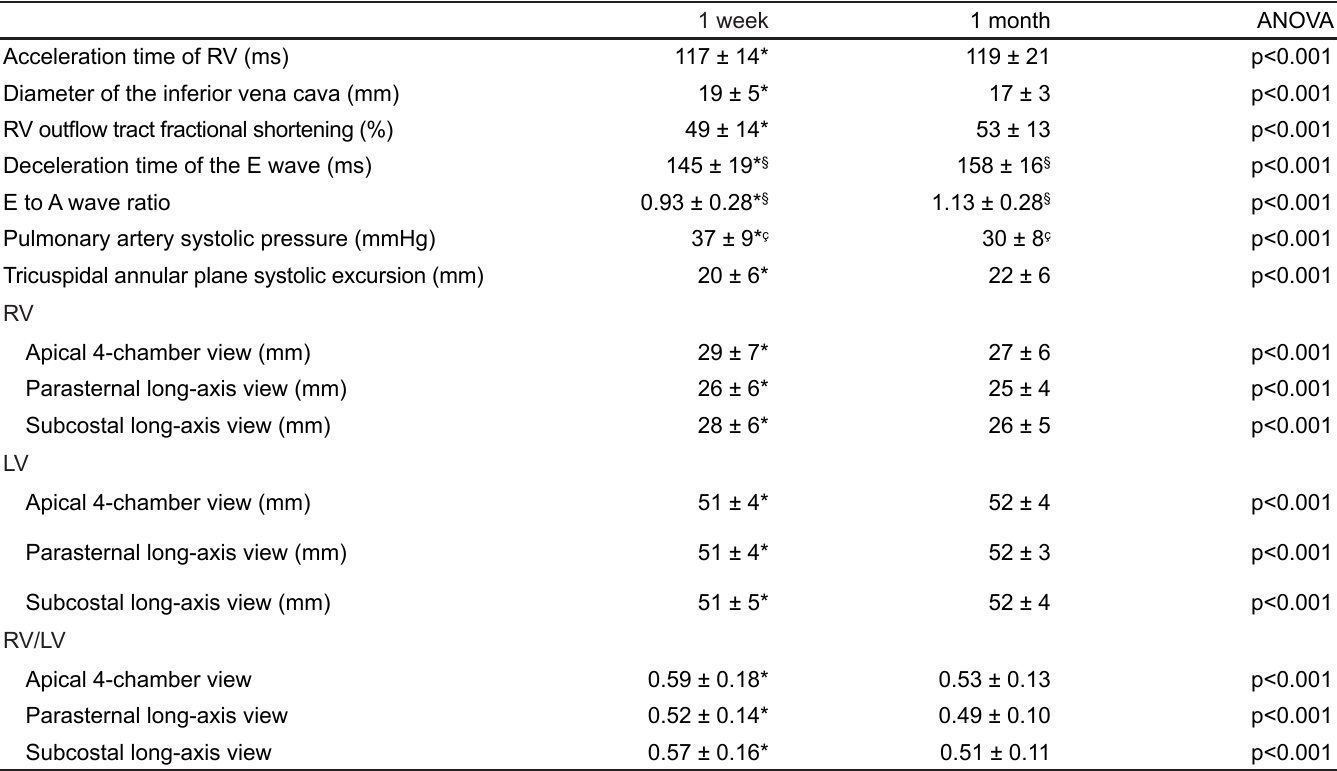
Table 2. Result of the comparison between the echocardiographic indices registered upon admission to the emergency department, after 1 week and after 1